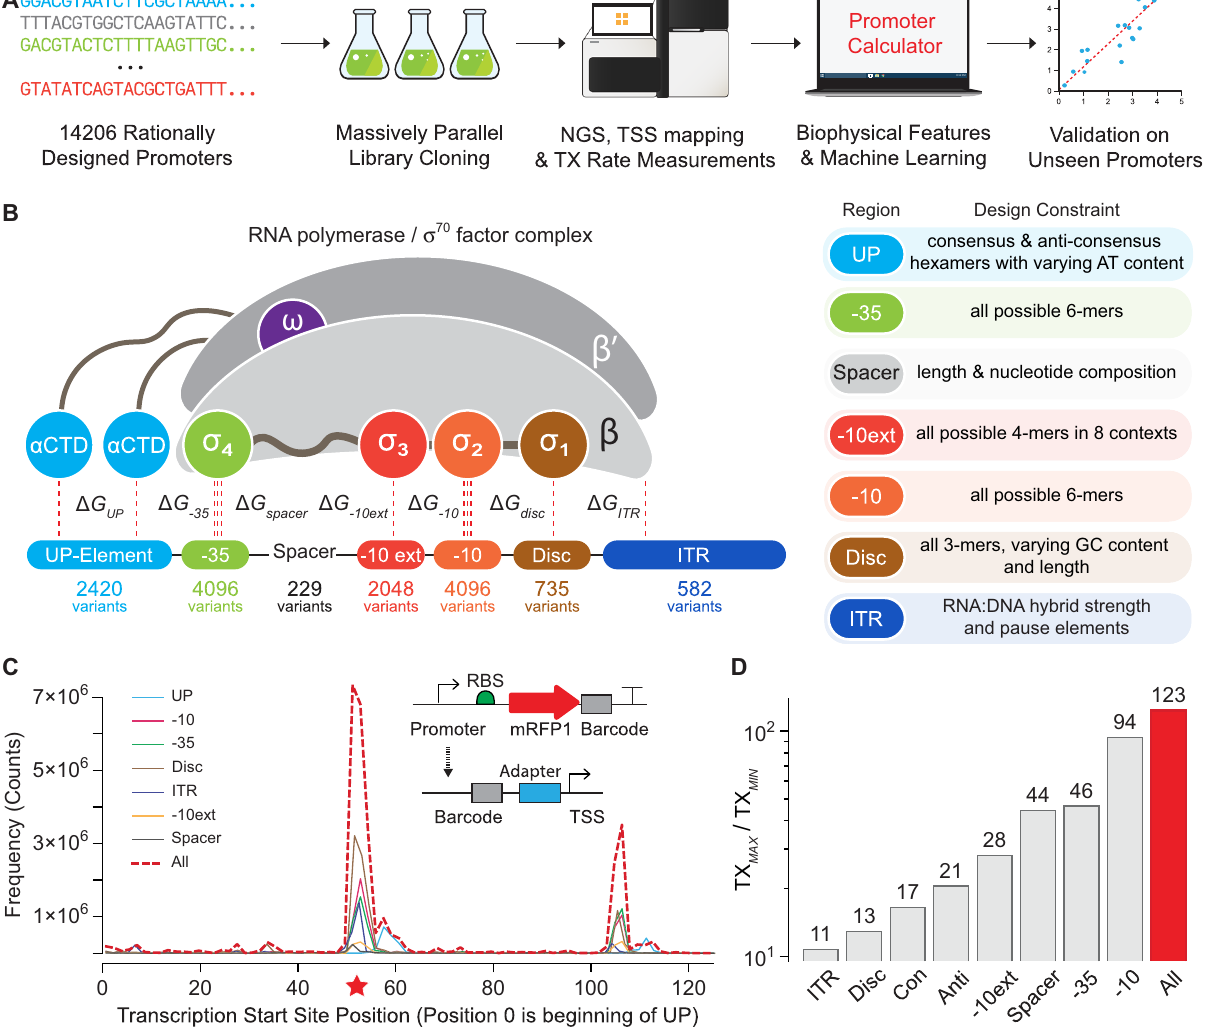
set of promoter variants. The star indicates the predominant start site. The inset schematic shows the system architecture, the locations of the promoter and bar- code variants, and the cDNA architecture after library preparation. D The tran- scription rates ’ dynamic ranges are shown for each set of promoter variants, considering only the predominant start site. Con: UP element promoter variants with consensus hexamers.Anti:UP element promotervariants